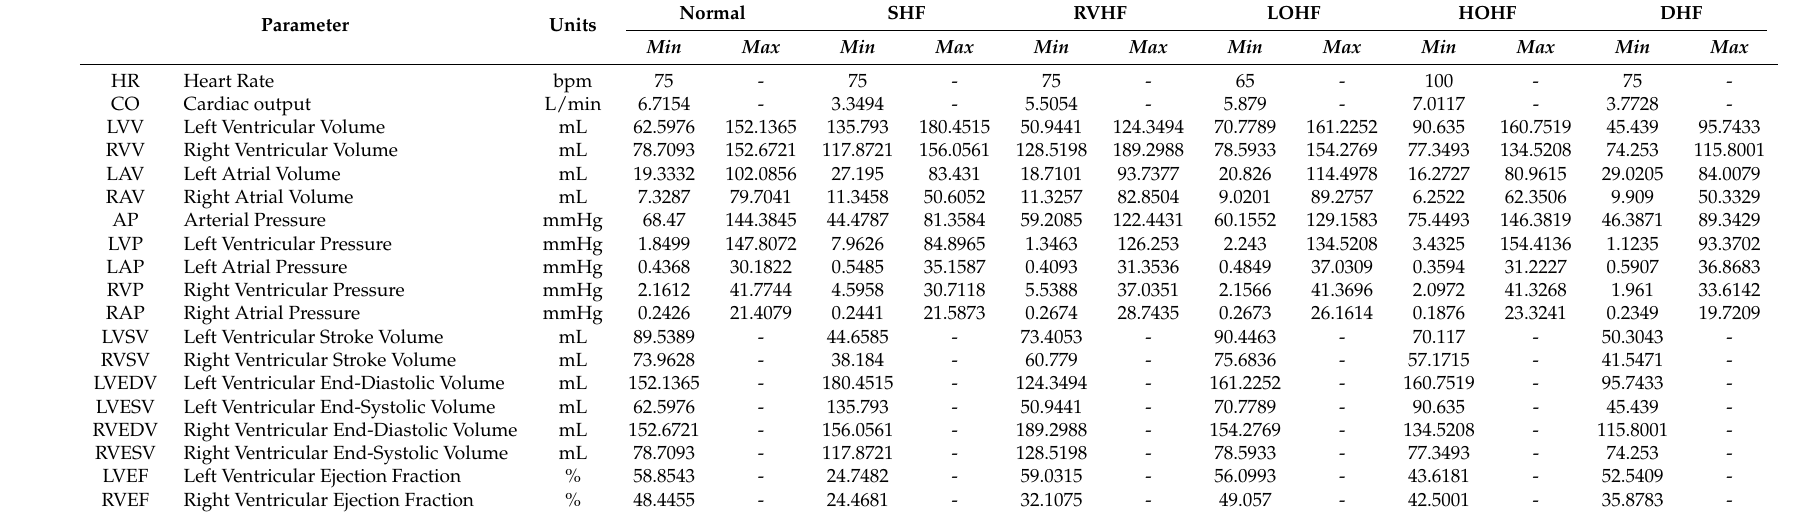
Table 3. Output hemodynamic values for different heart failures in the